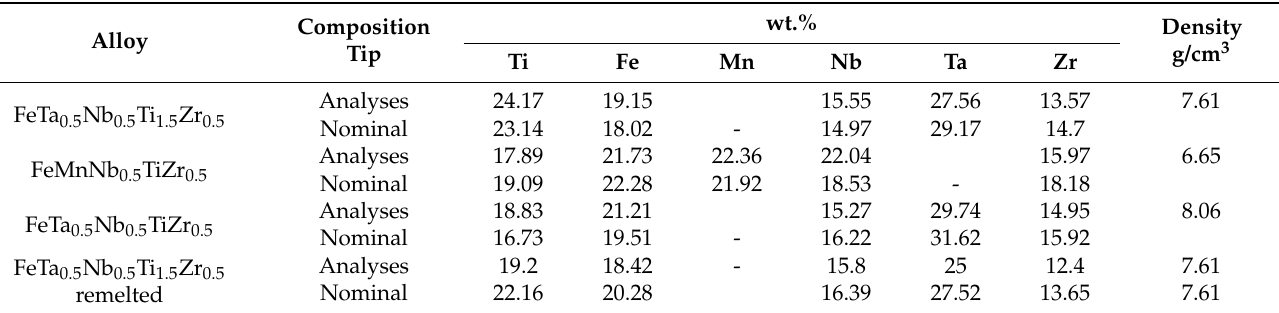
Table 3. The chemical composition and density of